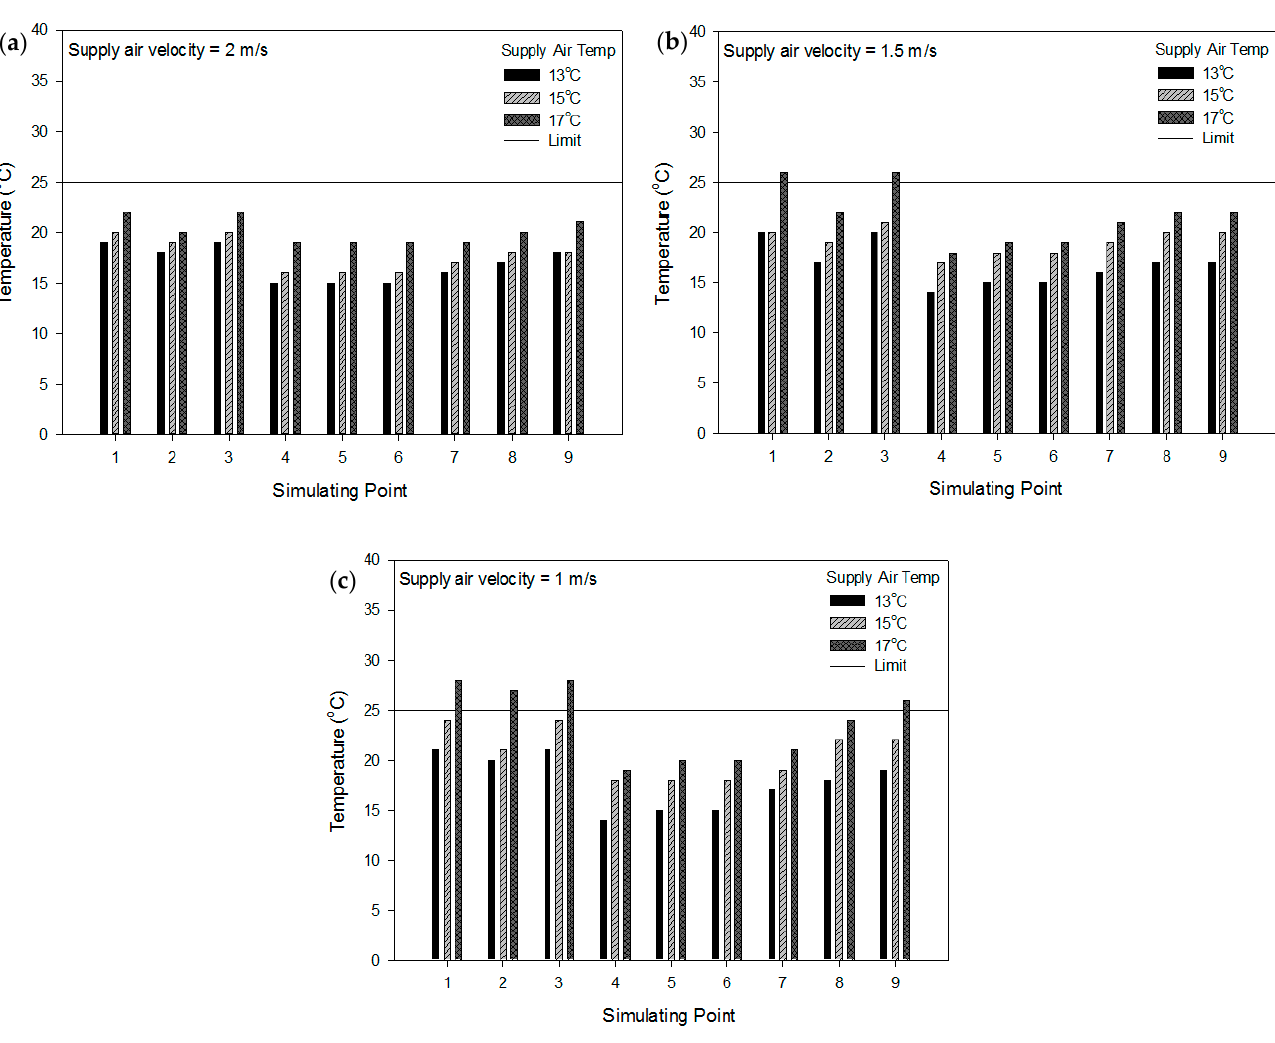
Figure 5. Temperature variation results in different temperature and air velocity settings. ( a ) supply air velocity at 2 m/s, ( b ) supply air velocity at 1.5 m/s, and ( c ) supply air velocity at 1 m/s. It is necessary to take energy consumption into consideration while enhancing the occupants’ indoor thermal comfort. The indoor thermal environment design should con- sider the actual demands and needs for thermal comfort. Gong et al. [38] observed the thermal comfort range at operating temperatures of 20.9–27.5 °C. The results demon- strated that 24.2 °C was the neutrality temperature determined by the regression ap- proach. In this study, the findings show that the temperature distribution, depending on the parameter selections, ranges from 18 to 26 °C, indicating a suitable indoor thermal environment. Furthermore, the best parameters should be selected to achieve a comforta- ble and acceptable indoor thermal environment. A configuration that delivers the supply air at a temperature of 15 °C and a velocity of 1 m/s may allow creating a comfortable indoor environment and present a neutral temperature when evaluating the PMV.